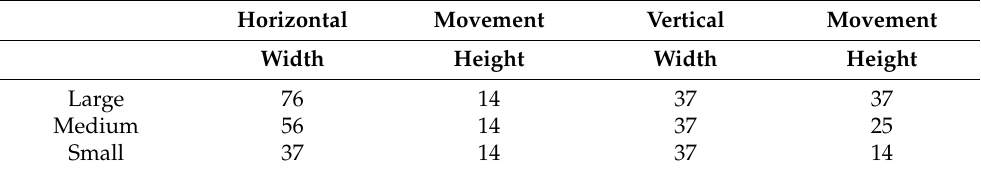
Table 1. Size of the keys on the keypad for both real and virtual conditions. Horizontal Movement Vertical Movement Width Height Width Height